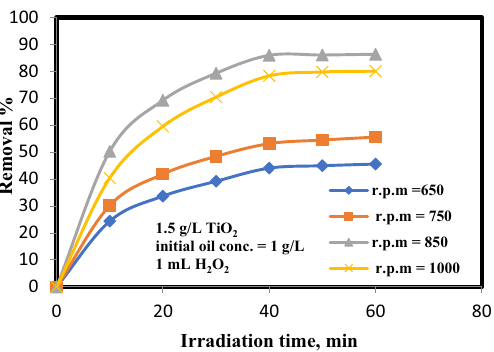
Figure 7. Influence of rotational speed on oil